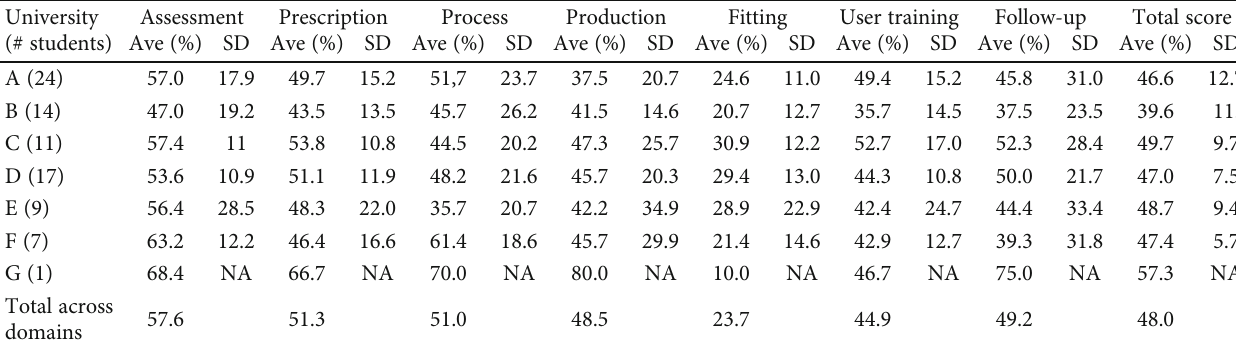
Table 2: Total and domain scores per